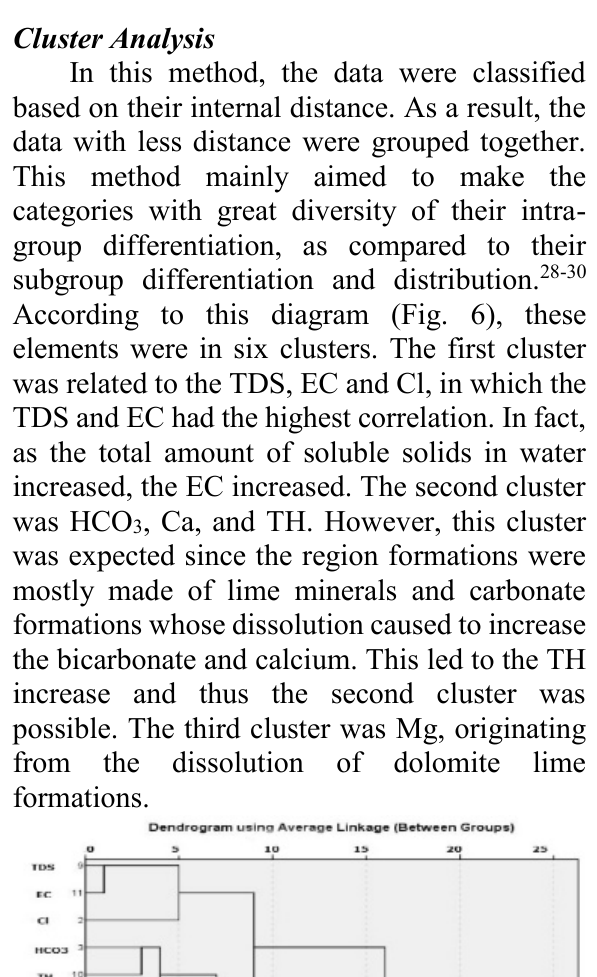
Cluster Analysis